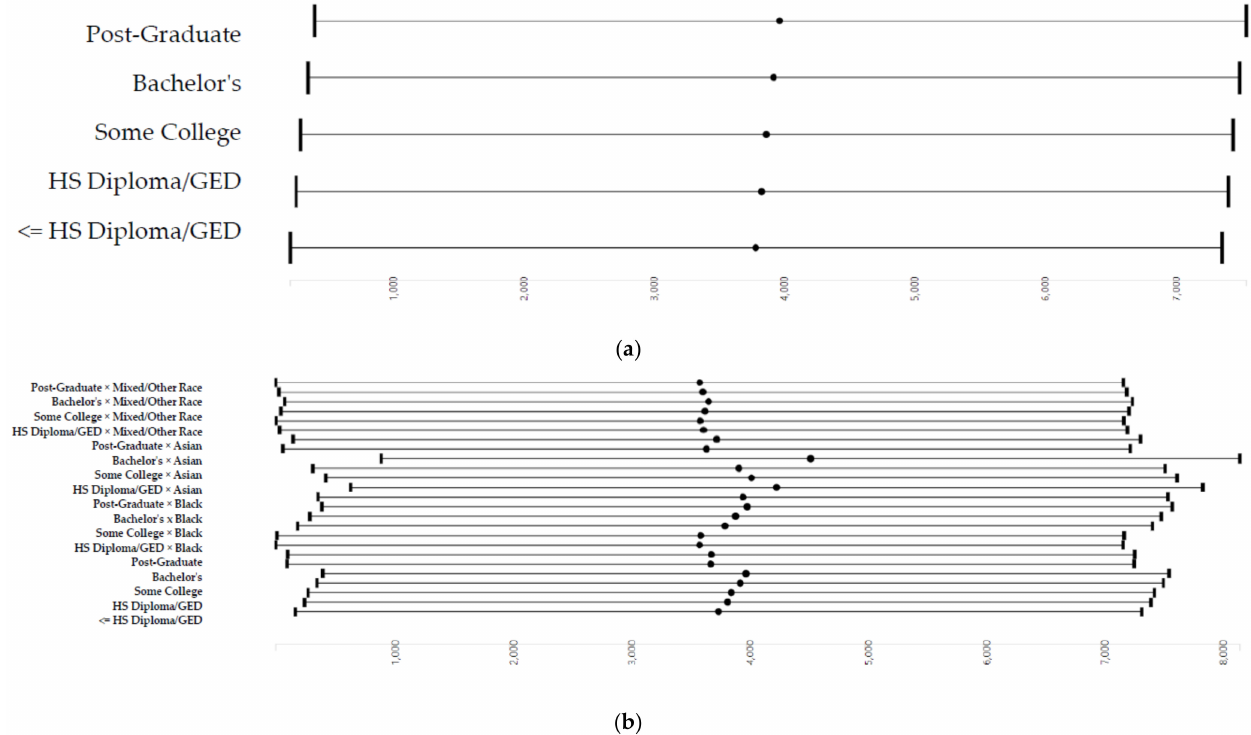
Figure A5. Association between parental education and children’s left superior temporal cortical surface area. In these figures, X represents children’s left superior temporal cortical surface area and Y represents parental education across racial groups. ( a ) Overall; ( b ) by